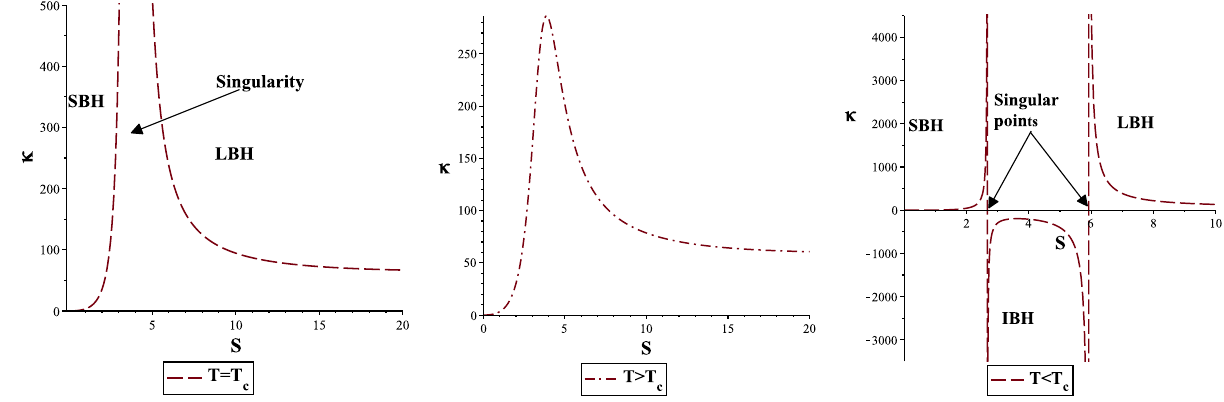
Fig. 14 κ versus S with a 2 = 2, e = 0 . 2 and g = 0 . 6. Left panel: T = T c , middle panel: T > T c and right panel: T < T c